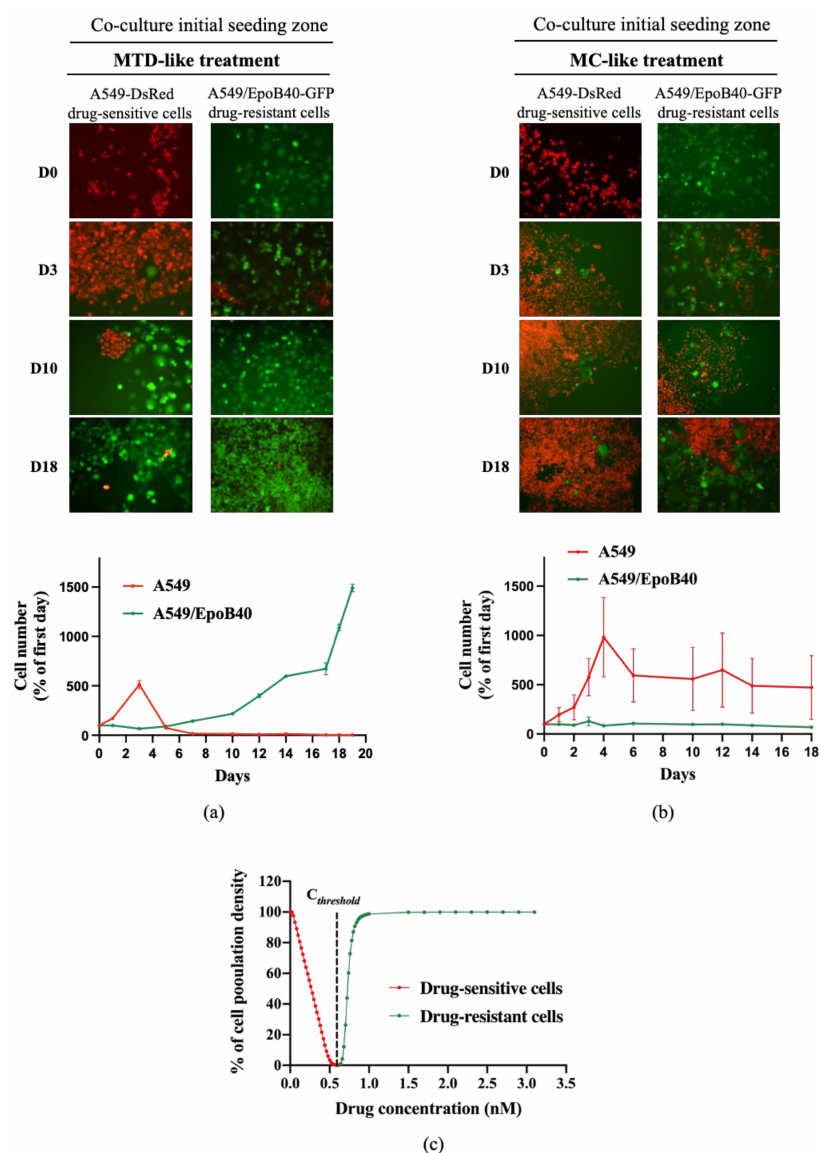
Figure 3. The metronomic schedule prevents the selection of drug-resistant clones in 2D NSCLC co-culture models. ( a , b ) Representative fluorescent pictures of A549-DsRed drug-sensitive cells and A549/EpoB40-GFP drug-resistant cells (magnification factor × 10) over time under MTD-like treat- ment ( a ) or MC-like treatment ( b ). Cell number of A549 and A549/EpoB40 by recording fluorescent signals (DsRed and GFP) over time under MTD- and MC-like treatments is also represented. Data were expressed as a percentage of cell number from day 0. ( c ) Percentage of the carrying capacity of the well occupied by cell populations after a 30-day in silico experiment depending on the drug concentration. Red: the well was mainly filled with drug-sensitive cells at the end of the experiment, and green: the well was mainly filled with drug-resistant cells at the end of the